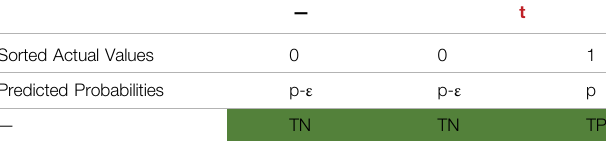
TABLE 7 | A group of realizations with N (cid:1) 3, AN (cid:1) 2, and AP (cid:1)